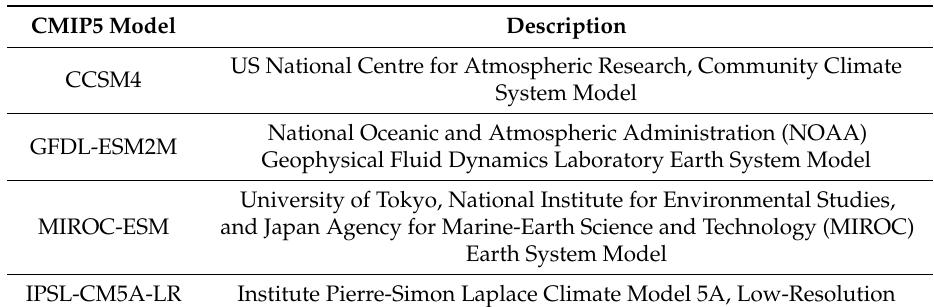
Table 2. Coupled Model Intercomparison Project Phase 5 (CMIP5) model descriptions and their origins, collected from U.S. Reclamation